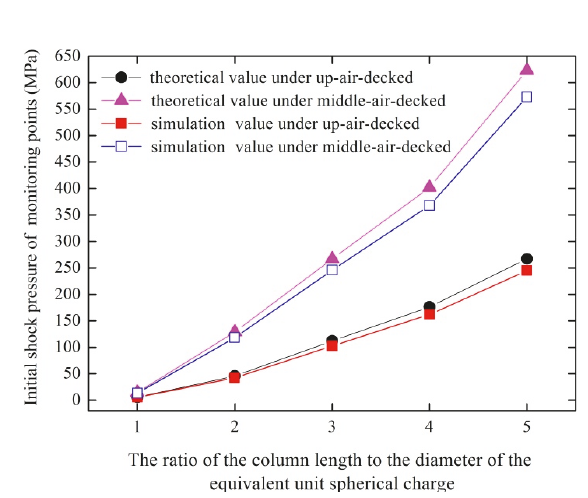
Figure 10: The variation in initial shock pressure with column lengths at specified